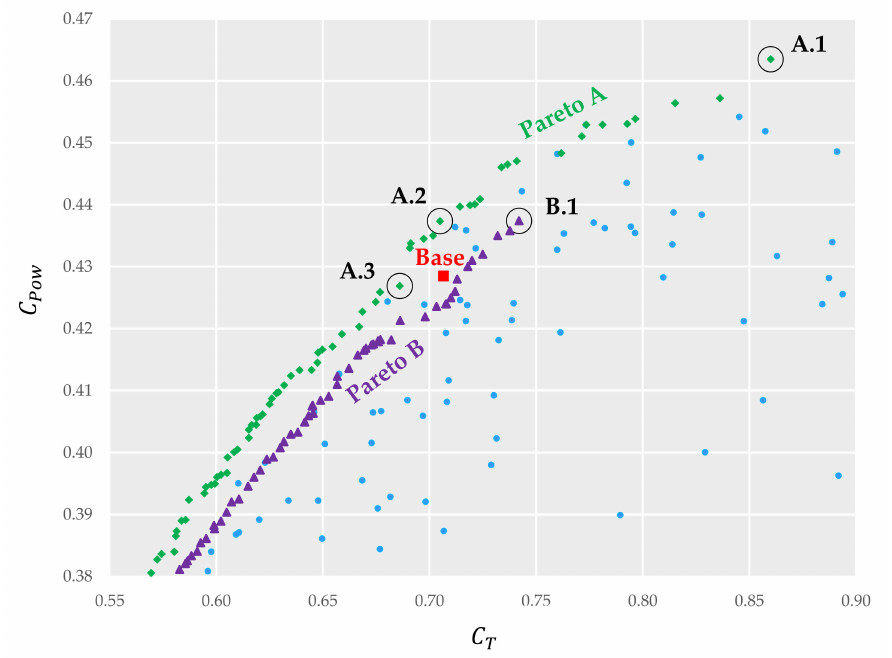
Figure 6. Pareto fronts for both optimization cases, with and without a constraint on C p . MIN